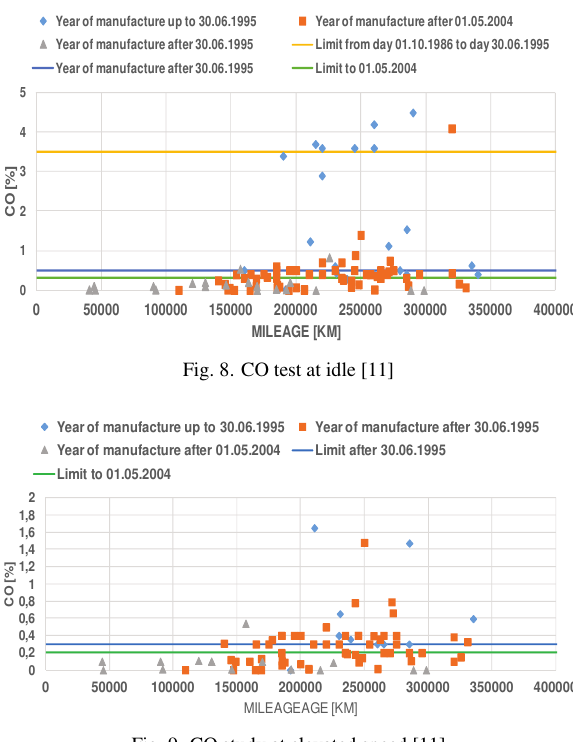
Fig. 9. CO study at elevated speed [11]